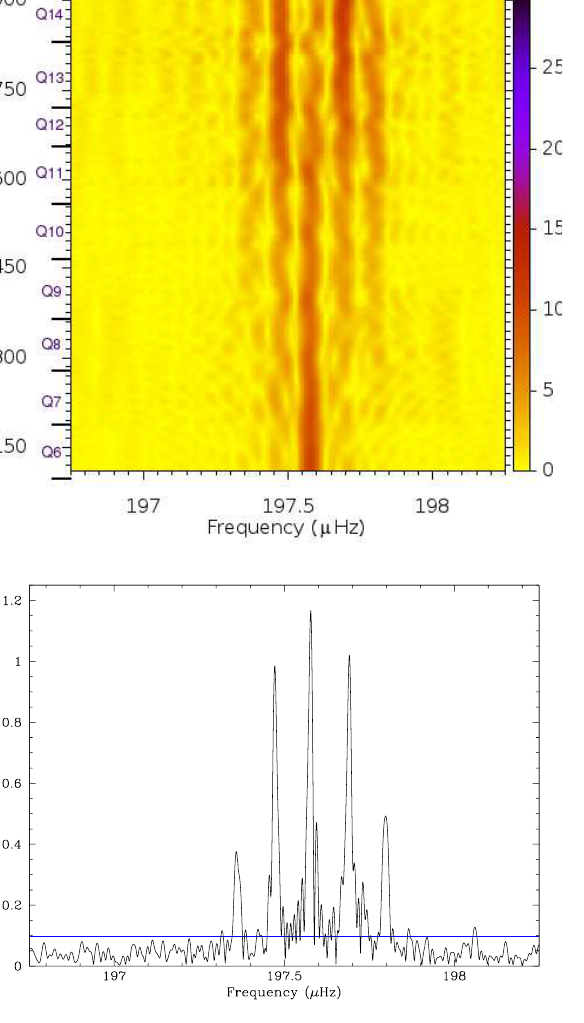
stars (Kern et al. 2017; Crooke et al. 2017; Baran et al. 2012), multiplets indicate solid-body rotation while in two oth- ers (Ketzer et al. 2017; Foster et al. 2015) the g −mode rota- tion period is several times longer than the p −mode